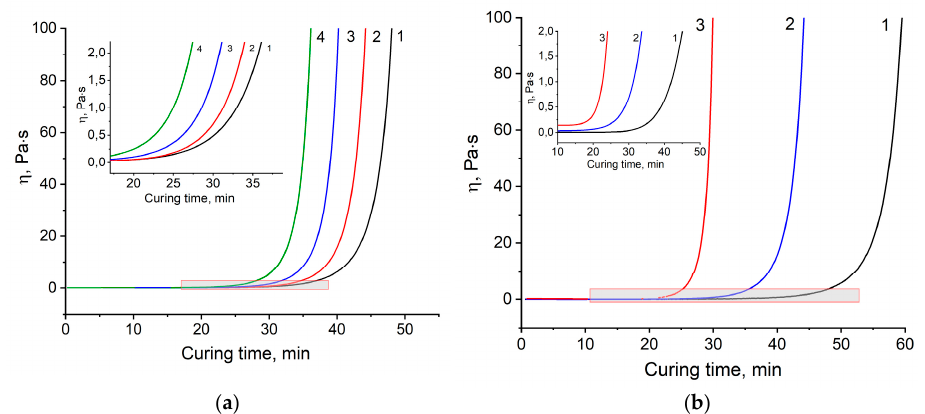
Figure 2. Dependencies of viscosity η on curing time: ( a ) at 170 ° С for formulations 1–4, ( b ) at 160 ° C (1), 170 ° C (2), 180 ° C (3) for formulation